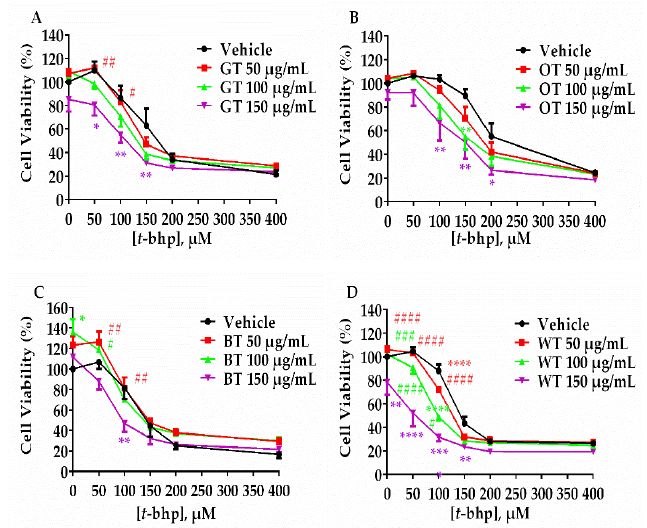
Figure 1. MTT assay of cell viability in response to 24 h incubation with t -bhp (0–400 µ M), alone or in the presence of ( A ) GT, ( B ) OT, ( C ) BT and ( D ) WT extracts (50, 100 or 150 µ g / mL). * p < 0.05, ** p <